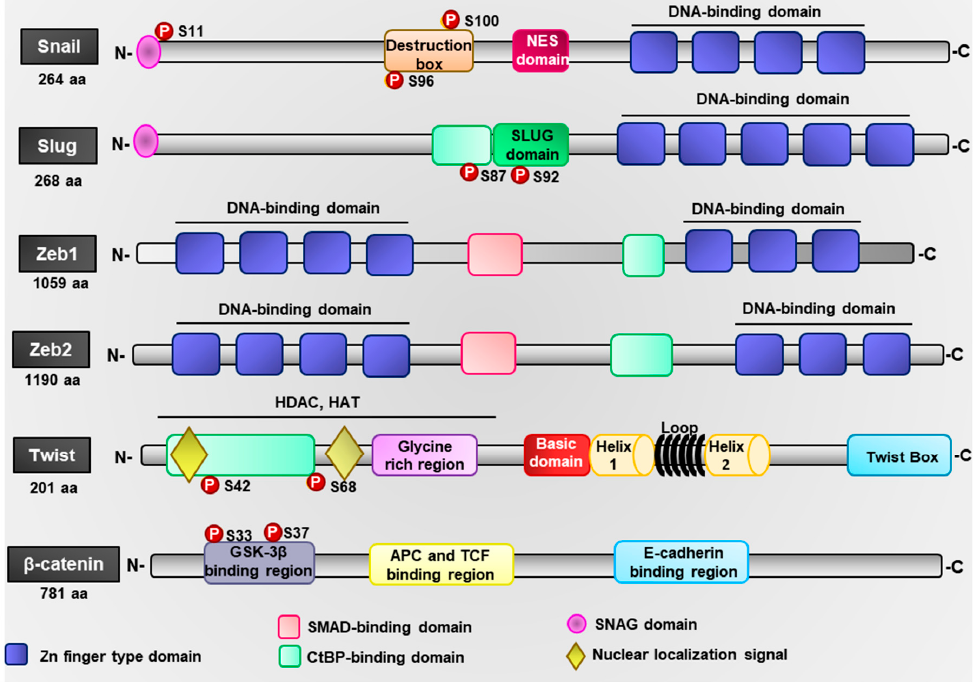
Figure 2. Schematic representation of leptin-induced transcription factors. Structural domains of the epithelial–mesenchymal transition (EMT)-related transcription factors (TFs), where the domains of DNA binding and interaction with other proteins are represented.